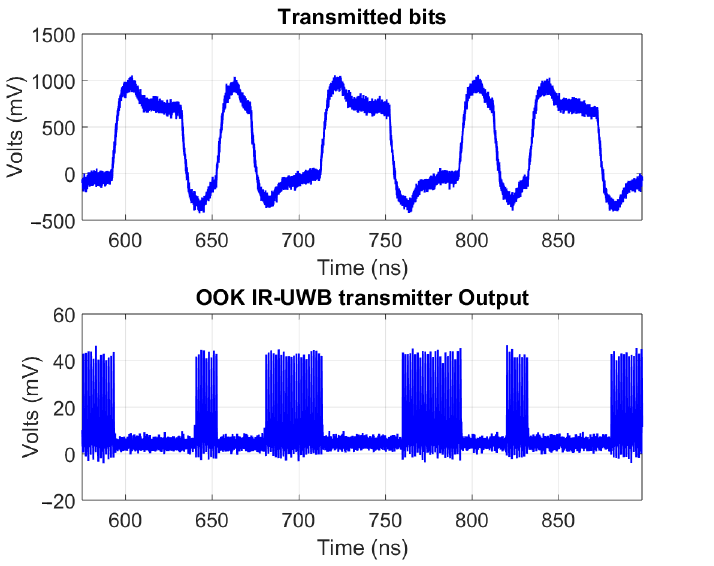
Figure 12. Measured time domain waveform of the IR-UWB transmitter at 50 Mbps bitstream, 1.3 V supply voltage. The top panel shows the input bitstream. The bottom panel shows the output of the transmitter IC, which is the modulated data. The measurement has been done without antennas for the sake of